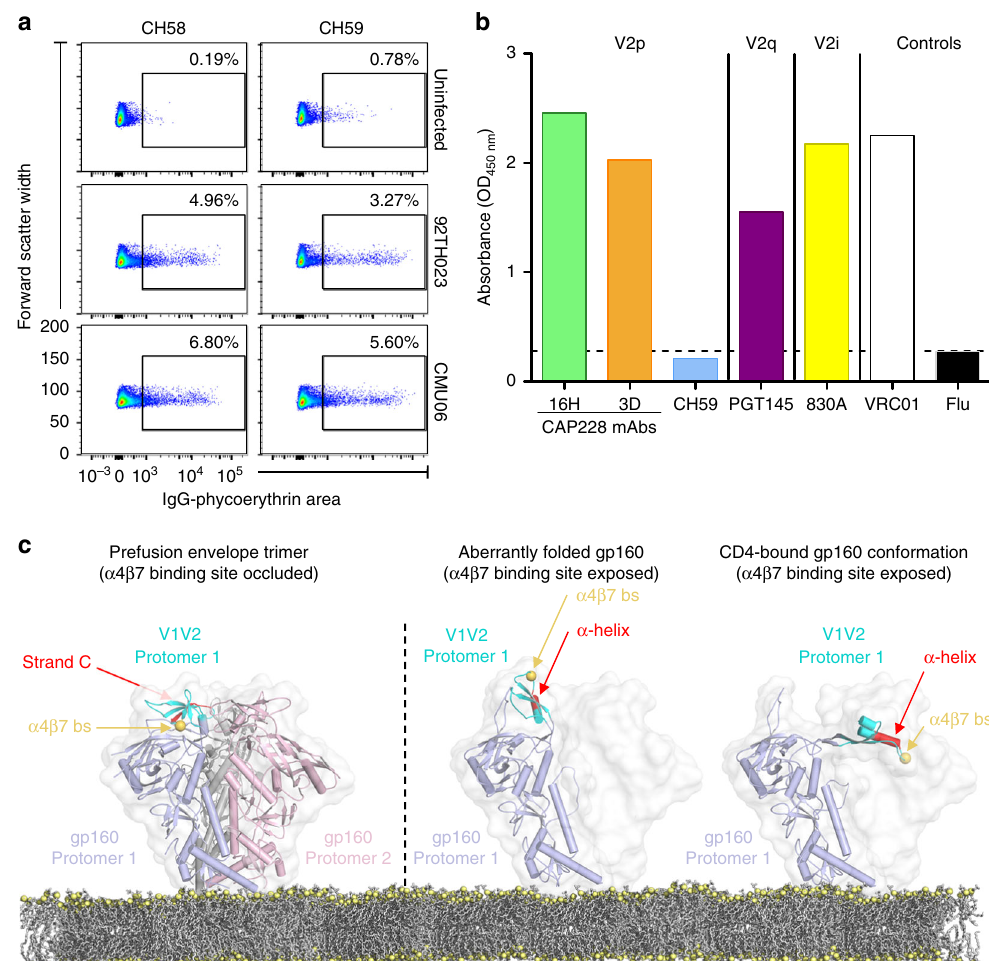
Fig. 6 The α -helical form of V1V2 potentially engages the α 4 β 7 integrin with high ef fi cacy. a Cell surface staining of HIV-1 infected CD4 + T cells (strains 92TH023 and CMU06) using RV144 mAbs CH58 (left) and CH59 (right). An uninfected control (top panels) was included to estimate background and showed minimal (<1%) staining of cells. Plots are shown as forward scatter (cell size indicator) vs. level of phycoerythrin conjugated staining of either mAb. b Endpoint ELISA binding titres of V2p mAbs CAP228-16H (green), CAP228-3D (orange) or CH59 (light blue), quaternary structure dependent V2q mAb PGT145 (purple) or V2i mAb 830 A (yellow) to concentrated pseudovirus expressing the C1080 envelope. HIV-1 CD4 binding site-speci fi c antibody VRC01, and an irrelevant Flu-speci fi c antibody were used as positive or negative controls, respectively. c Models of the HIV-1 prefusion Env trimer (left), misfolded/refolded helical V1V2 (centre) or gp160 that has adopted the CD4-bound conformation (right) are shown. The latter two conformations of Env display highly exposed α 4 β 7 binding sites (gold spheres) within helical V1V2, providing a potentially functional role for aberrant Env on the viral surface in